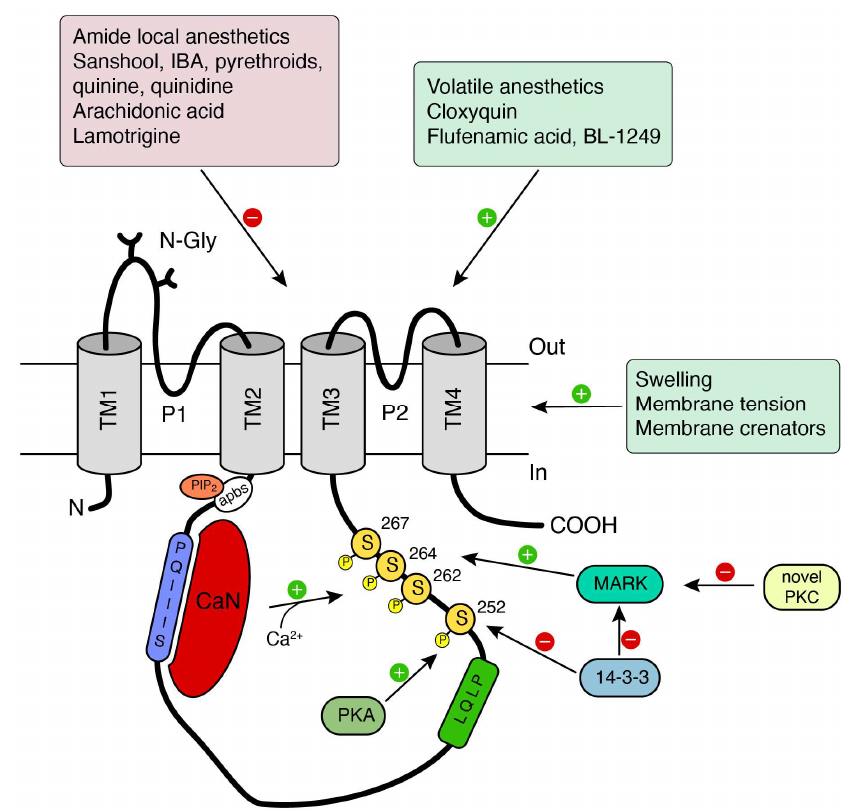
Figure 2. Regulation of TRESK by extracellular stimuli or by intracellular pathways and interacting figure 2 proteins. Schematic model of the human TRESK channel in the resting state. Known activators and inhibitors / blockers of the channel are indicated on top, as well as stimuli that modulates channel function through the membrane. Regulatory and interaction sites with membrane lipids and PIP 2 (apbs) or calcineurin (PQIIIS and LQLP) are shown. Calcineurin interacts with the LQLP motif upon calcium binding to dephosphorilate serines S262, S264, and S267. Other regulatory proteins (PKA, 14-3-3 and microtubule a ffi nity-regulating kinases (MARK) and sites of action are